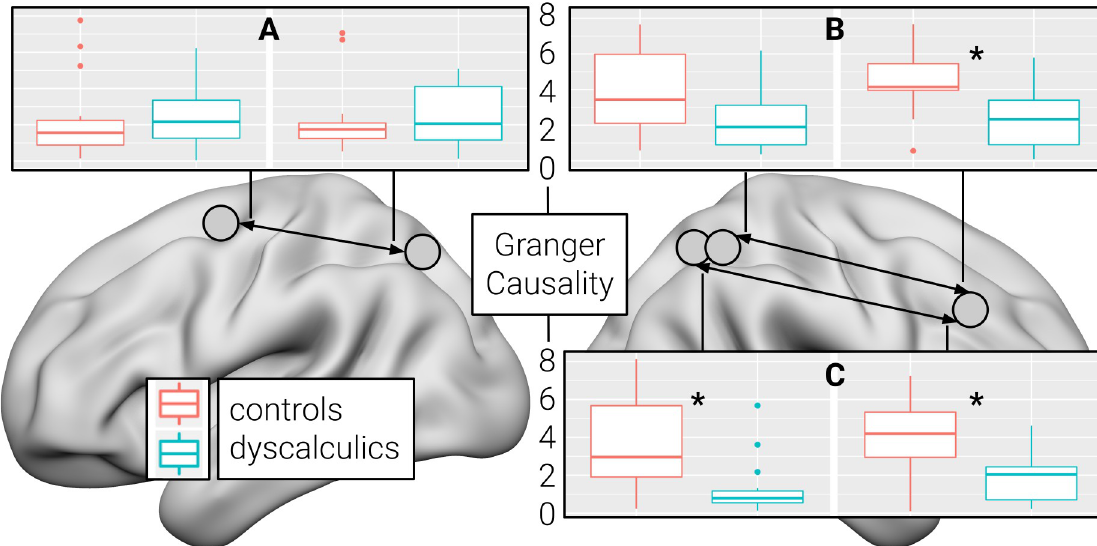
Fig 3. Effective connectivity differences. Granger causality indices for pairs of regions of interest derived from ( A ) the regional homogeneity of the left PPC and the left DLPFC, ( B ) the amplitude of low-frequency fluctuations of the right PPC and the degree centrality of the right DLPFC, and ( C ) the regional homogeneity of the right PPC and the degree centrality of the right DLPFC. Arrows indicate the direction of the influence of one hemodynamic time series onto the other. Vertical lines at the top and the bottom of the bars depict the SD. Horizontal lines within the bars represent the group median. Dots denote single cases that are more than 1.5 SDs away from the group mean. Asterisks indicate significant differences between children with dyscalculia and controls at a threshold of P < 0.05 (family-wise error corrected). The numerical data used in this figure are included in S3 Data. D AU : AbbreviationlistshavebeencompiledforthoseusedthroughoutFigs 3 and 4 : Pleaseverifythatallentriesarecorrect : LPFC, dorsolateral prefrontal cortex; PPC, posterior parietal cortex.